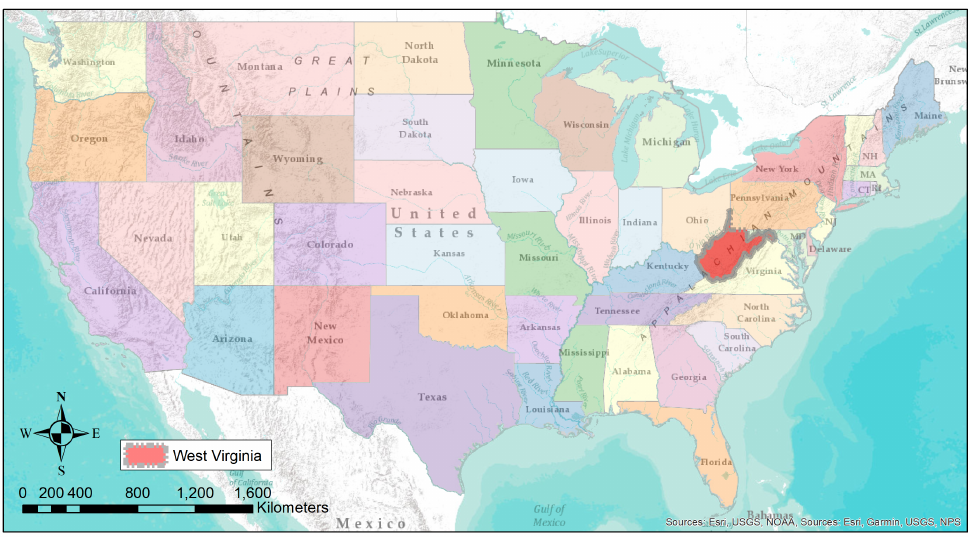
Figure 1. West Virginia (WV) State in the US (Data Source